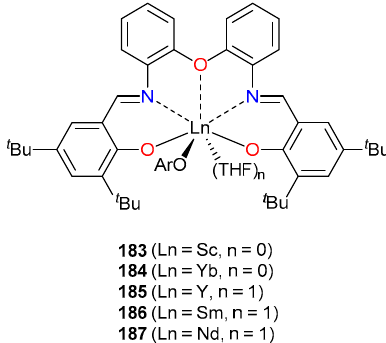
Figure 33. Rare-earth metal complexes of [ONONO]-type Salen ligands active in the ROP of r -LA [94].